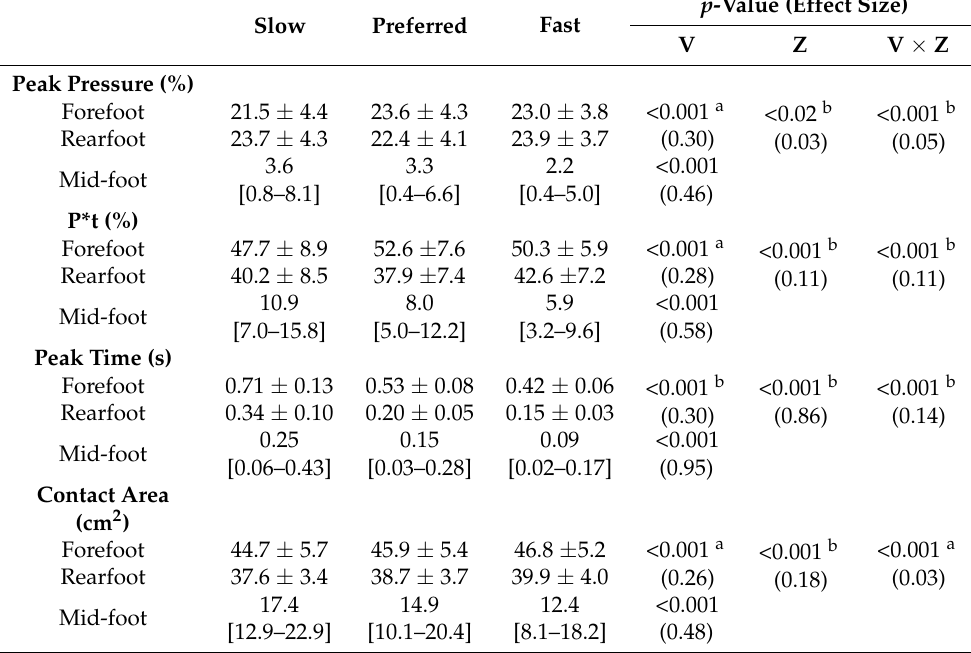
Table 3. Fore- and rear-foot mean ± SD and mid-foot median [interquartile range] of plantar pressure parameters for the three different velocity conditions; computed on all subjects ( n = 170). For the fore- and rear-foot, p -values reflect the effects of velocity (V, in the first column), zone (Z, in the second column) and velocity-zone interaction (V × Z, in the third column) through the results of the mixed-model ANCOVA (covariates appearing in the model are evaluated for the following values: age = 42.5 yrs). When a significant difference occurred, effect sizes are reported in brackets as partial eta-squares (part. η 2 ≈ 0.01 indicates a small effect, part. η 2 ≈ 0.06 indicates a medium effect and, part. η 2 ≈ 0.14 indicates a large effect). For the mid-foot, p -values display the velocity effect (V, in the first column) analysed using a Friedman rank test. Effect sizes for significant effects are reported Table 1. Mean ± SD of subject characteristics. p -values are the results of a Mann — Whitney U Test in brackets after p -values as average rank r (with r ≈ 0.1 indicating a small effect, r ≈ 0.3 a medium by sex and effect size r is computed using the Rosenthal equation [28]: 𝑟 = 𝑧 √𝑁⁄ (with a small effect and, r effect when r ≈ 0.1, a medium effect when r ≈ 0.3 and a large effect when r ≳ 0 .5). 0.5 a large effect). Comparisons between medial and lateral zones can be found in the supplementary materials (Tables S2 and